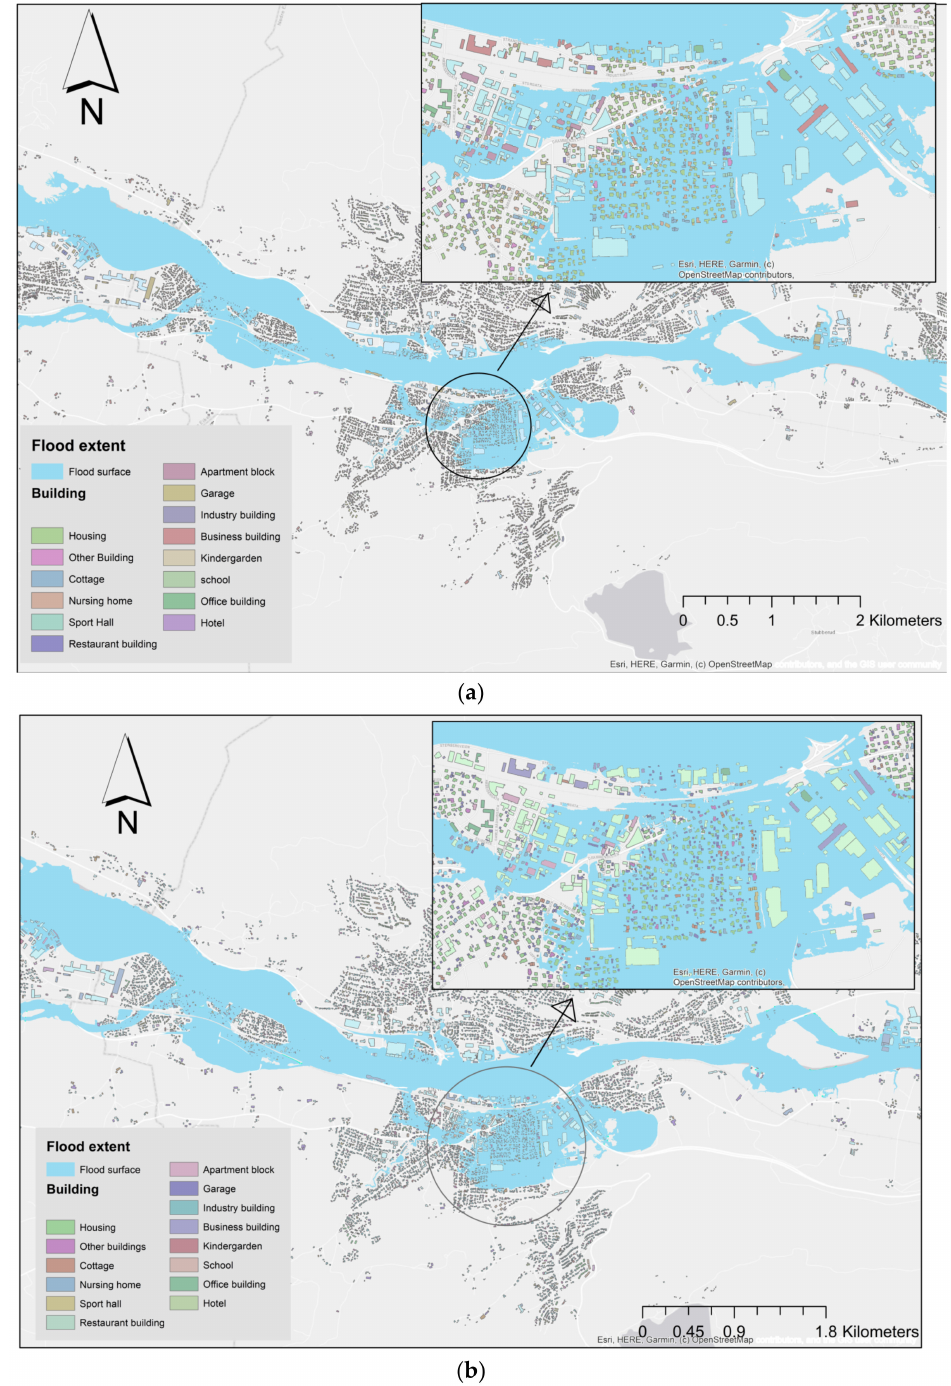
Figure 5. Flood inundation map: ( a ) Q200 for current climate scenario, and ( b ) Q200 for future flood scenario. The colours in the above figures show different types of buildings and flooded surface in the study